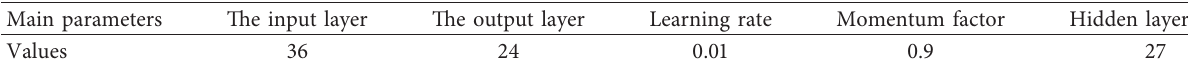
Figure 5: Variation of fitness of GA. Table 2: Main model parameters.